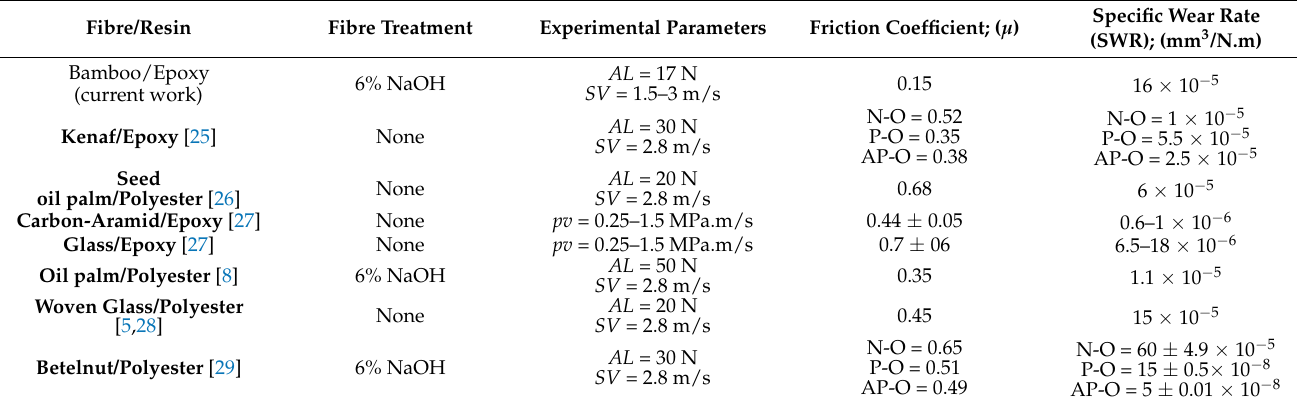
Table 5. Comparison of specific wear rate (SWR) and friction coefficient of various natural fibres and synthetic fibres reinforced polymeric composites with the bamboo fibre reinforced epoxy (S-BFRE) composite under dry sliding conditions.